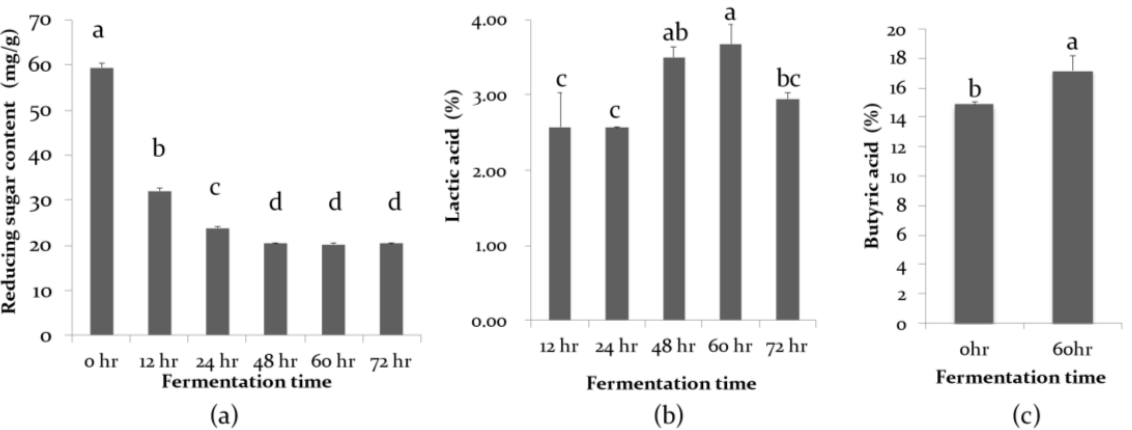
Figure 3. Effect of 55% initial moisture of fermentation okara and CM with the combination of mixed probiotics and NSPases supplementation on reducing sugar content ( a ); lactic acid contents ( b ); and butyric acid contents ( c ) with different fermentation durations. Values are expressed as mean ± SD ( n = 3). a–d Means of different fermentation during time treatment with different superscript letters are significantly different at p < 0.05.